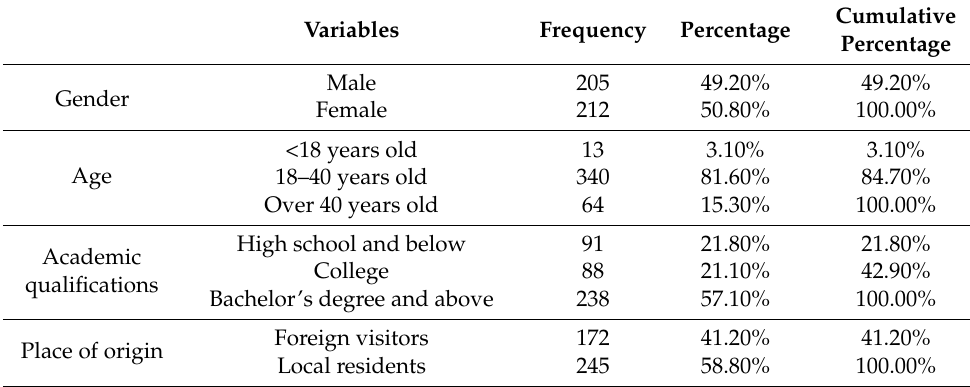
Table 2. Demographic characteristics of